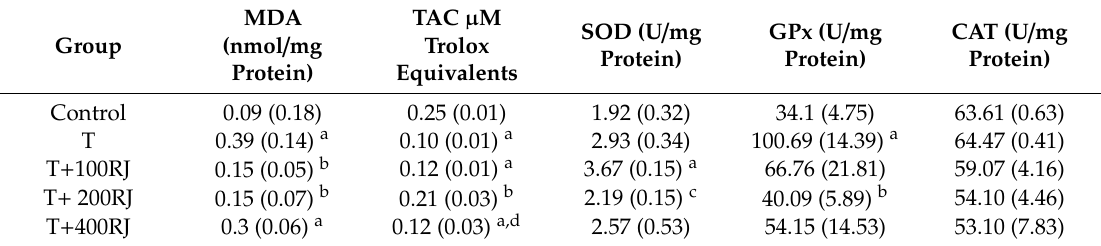
Table 5. Ovarian oxidant / antioxidant status in all experimental